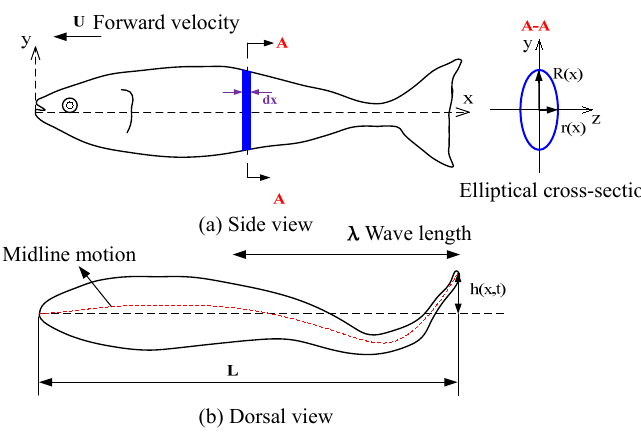
Figure 1. Illustration of kinematics variables used to describe the swimming fish. L : full length of fish body; R ( x ): half-height; r ( x ): half-width.